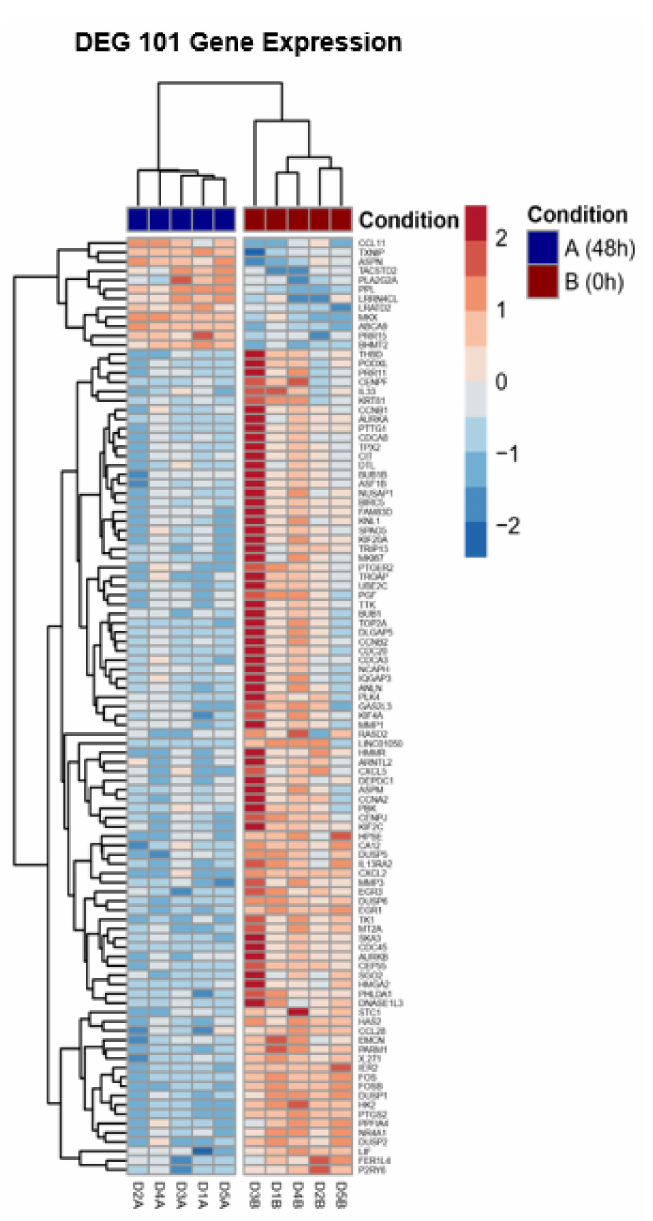
Figure 3. Hierarchical cluster analysis of the 101 significant differentially expressed genes. It repre- sents normalized gene expression of each